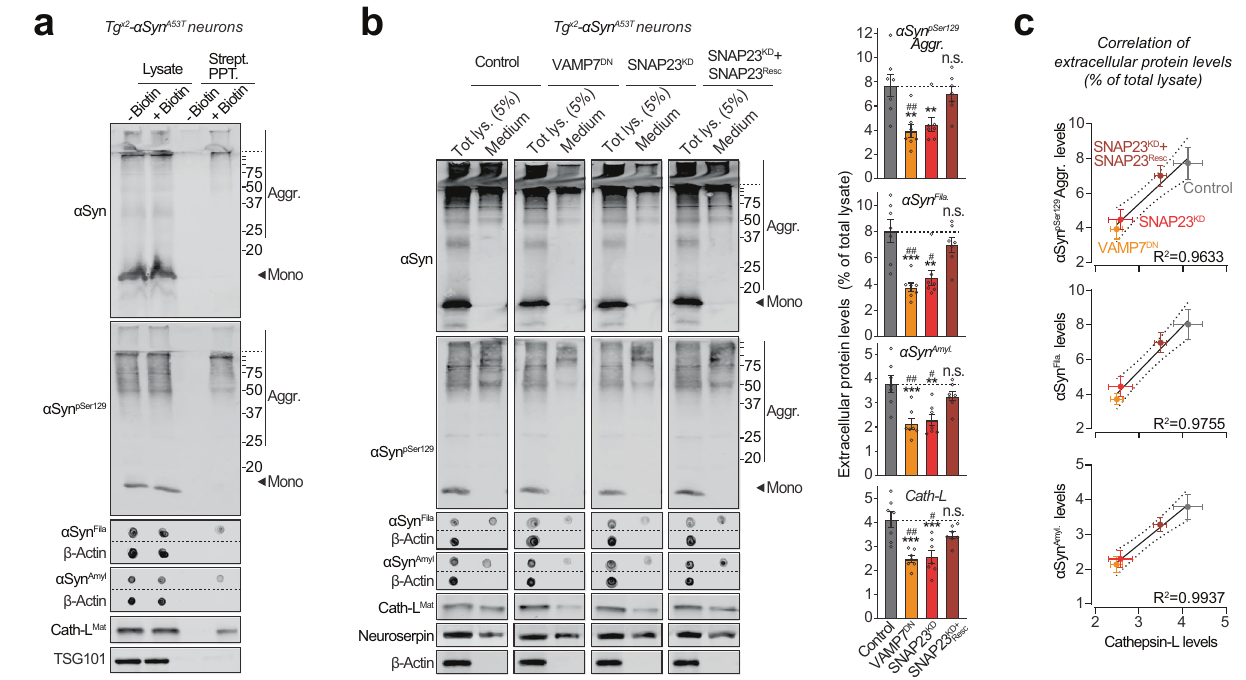
Fig. 5 | Pathogenic α Syn species are secreted from neurons via SNARE- dependent lysosomal exocytosis. a Tg x2 - α Syn A53T primary neurons lentivirally expressing a synapsin-1 promoter-driven Apex-2 LAMP1 (infected on DIV7) were sub- jected to proximity-labeling on DIV 47. Biotinylated proteins released into the media during 48h (by DIV49) were precipitated on streptavidin-magnetic beads and immunoblotted forthe indicated α Syn species ( α Syn, α Syn pSer129 , α Syn Amyl , and α Syn Fila ), lysosome-luminal protein cathepsin-L, and exosome luminal protein TSG101. Strept. PPT. streptavidin precipitate. Membrane-matched dot blots ( β - Actin=loading control) are separated by dashed lines. (representative of n =3). b Media collected over 2 days (DIV 47 – 49) from Tg x2 - α Syn A53T primary neurons lentivirally expressing control (GFP), GFP-VAMP7 DN fragment, SNAP23 KD shRNA, andSNAP23 KD shRNAplusknockdown-resistantSNAP23rescue-construct(infected on DIV7) were immunoblotted for the indicated α Syn species ( α Syn, α Syn pSer129 , α Syn Amyl , and α Syn Fila ), cathepsin-L (Cath-L Mat ; late-endosome/lysosome-luminal), neuroserpin (non-lysosomally/constitutively secreted from neurons), and β -actin